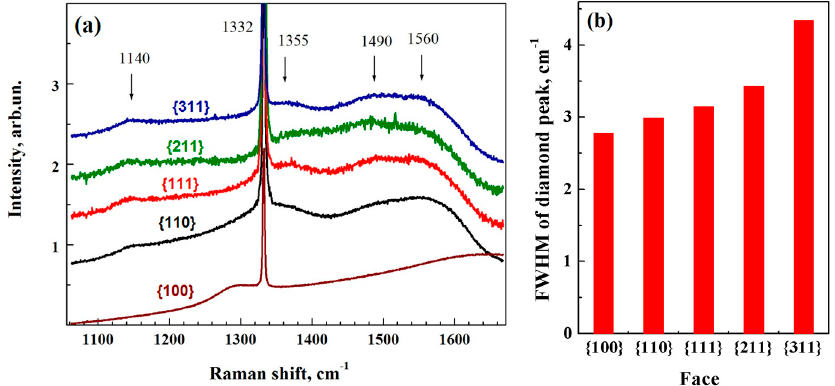
Figure 2. ( a ) Raman spectra on different faces after 5-min growth. The spectra are shifted along the vertical scale for clarity. Two broad bands at 1290 and 1650 cm − 1 on {100} face are due to photoluminescence of H3 defect center [25]. The Raman spectra were normalized to the 1332.5 cm − 1 peak intensity; ( b ) Diamond Raman peak width (FWHM) for CVD film on different faces.